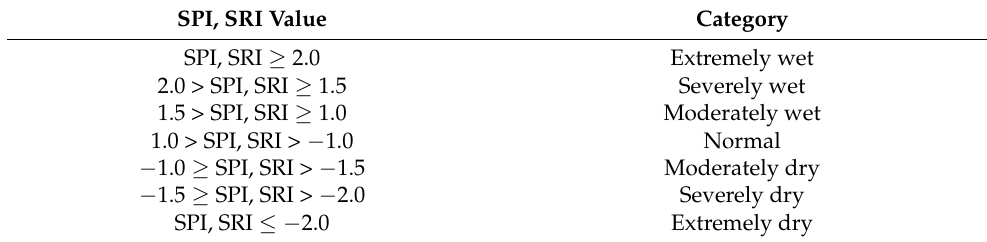
Table 1. The classification scale for the SPI and SRI values [14,30,34]. SPI, SRI Value SPI, SRI ≥